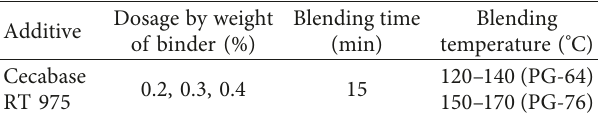
Table 2: Dosage, blending time, and temperature of the additive.